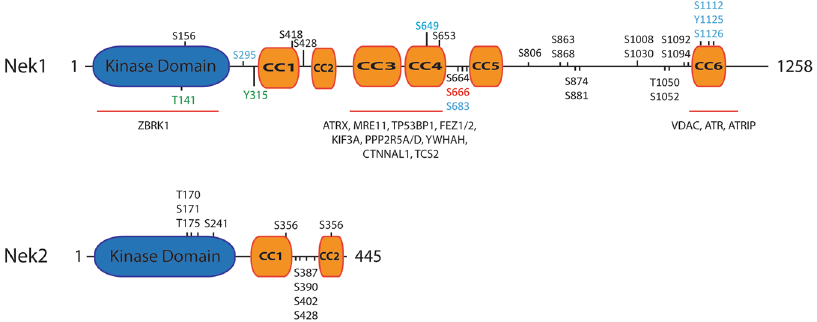
Figure 5. Schematic diagrams showing the domain organization and reported phosphosites of NEK 1 and NEK 2. NEK 1 and NEK 2 have a highly conserved kinase domain (blue) but differ in the composition and length of their C-terminal regulatory domains. NEK 1 has 6 predicted coiled-coil (CC) domains (CC1 to CC6, in orange). Its CC1 and CC2 are homologous to the 2 coiled-coils found in NEK 2. Selected NEK 1 interacting proteins are shown above those structural regions with which they have been found to interact 8, 16 . Furthermore, are depicted both previously known or identified phosphorylation sites (this work) identified in non-treated cells (blue), cisplatin (red) or in in cells from both treatments (black). The phosphorylation sites are represented as the amino acid number and kind: serine (S), Threonine (T) or tyrosine (Y) and their position in the primary structure. Green residues were recently identified as phosphorylated by TLK1 57 . Auto-phosphorylation derived residues in NEK 2 are depicted as previously reported by Rellos et al . 28